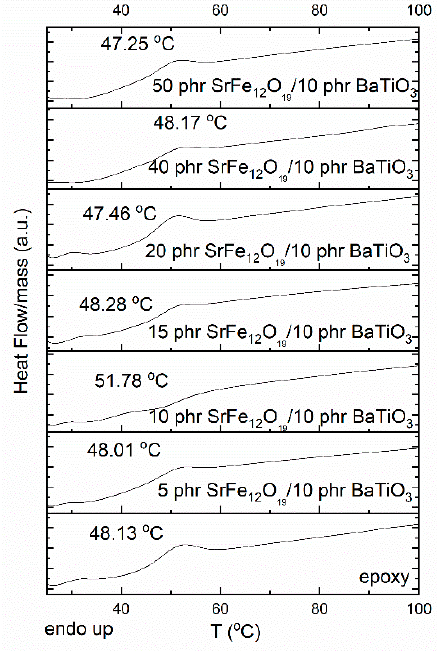
Figure 14. DSC thermographs for all the studied systems.